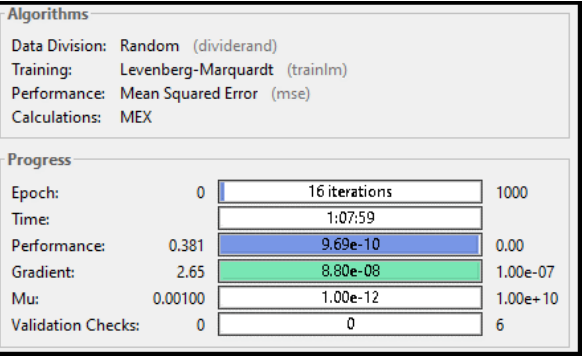
Figure 16. Algorithm used in NET2_STATE neural network and data regarding the learning process.